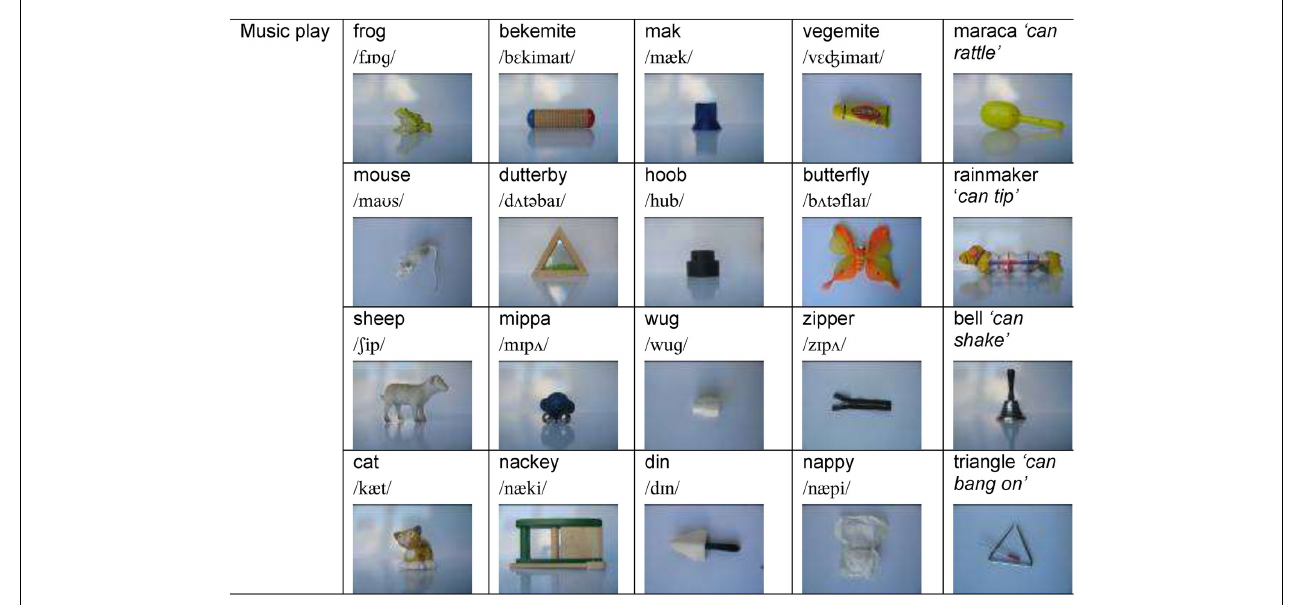
FIGURE 2 | Music-play stimuli in theAFC